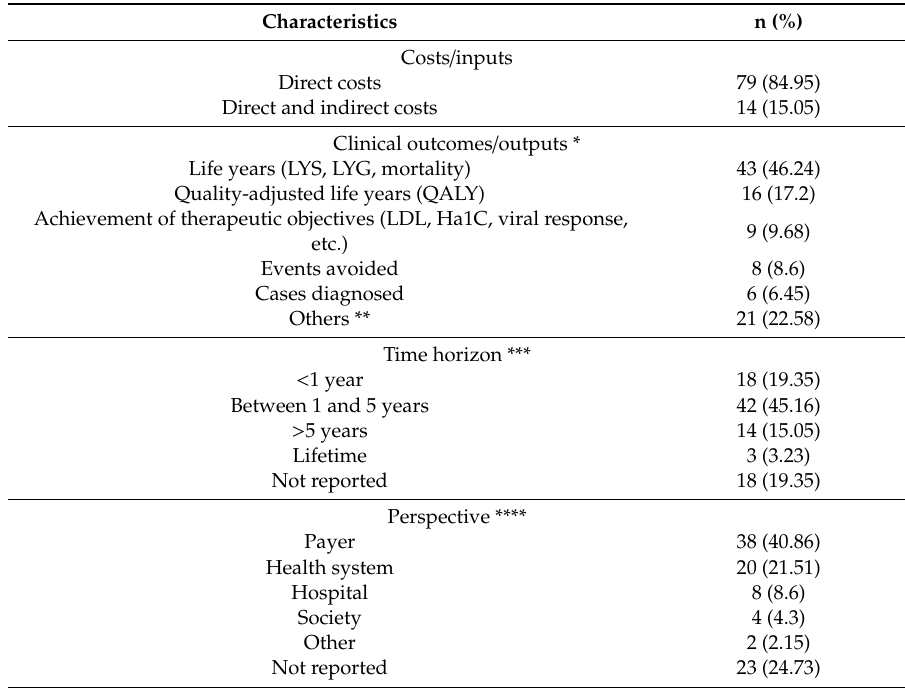
Table 3. Methodologic information about economic